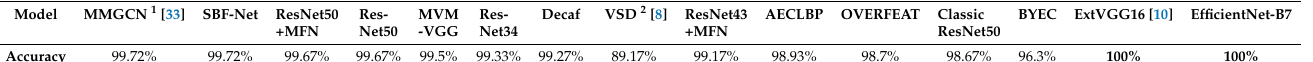
Table 2. Comparison of the classification accuracy of different models on the NEU dataset. If not specified then information is based on [29]. Training/testing ratio is 80/20 in general. Best values are highlighted in bold.